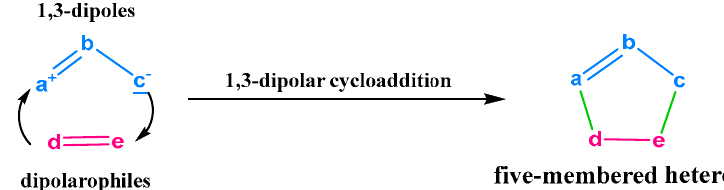
Figure 1. Huisgen reaction mechanism.